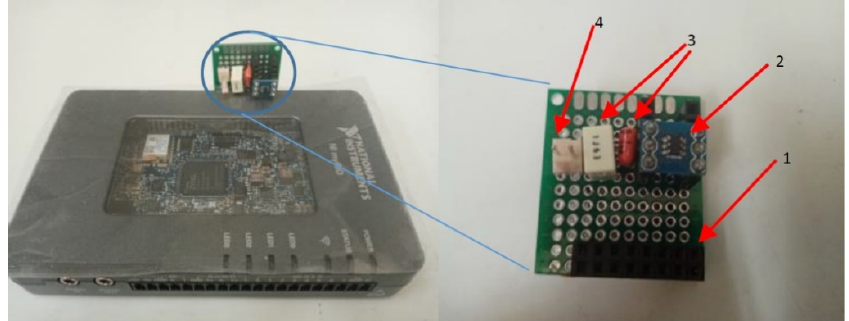
Figure 16. Custom ADC card attached on the MyRio device. ( 1 ) Bus connector; ( 2 ) ADC chip; ( 3 ) Coupling capacitors; ( 4 ) Input signal.